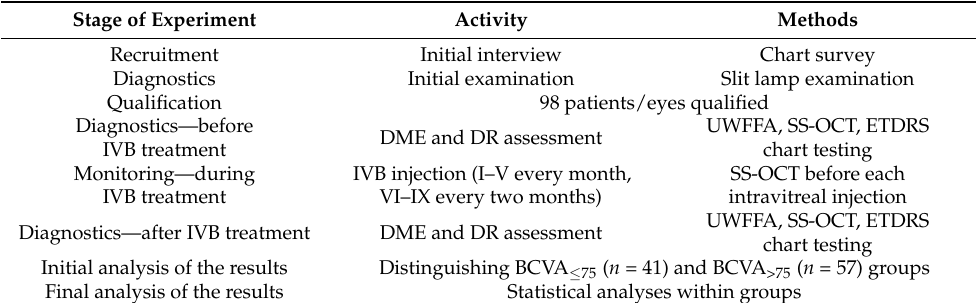
Table 1. Study design and flow of patients with diabetic macular edema (DME) taking part in the experiment assessing the effectiveness of intravitreal bevacizumab